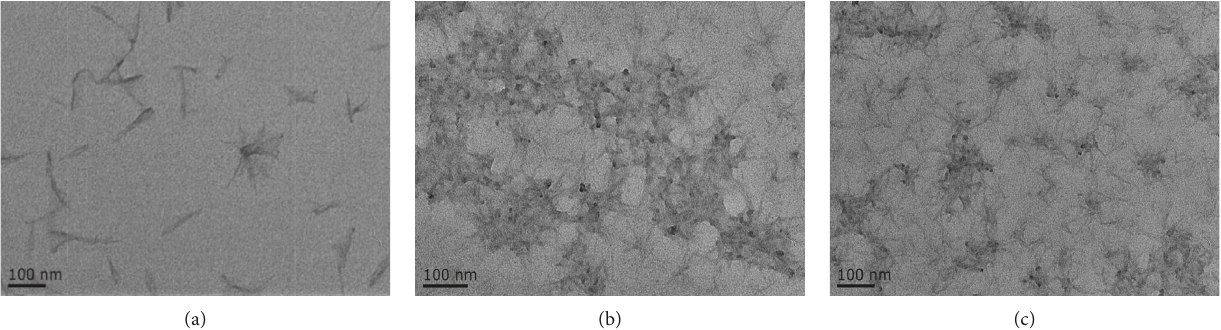
Figure 4: TEM images of (a) the NRPCNSs, (b) the Ag + -NRPCNSs, and (c) the Ag + -NRPCNSs in the presence of